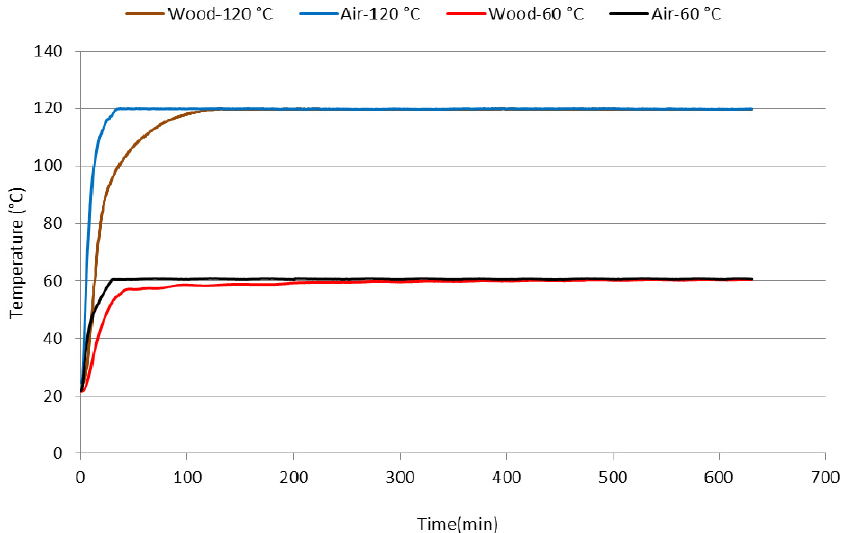
Figure 1. Temperatures in the dryer and in samples during the thermal treatment at 60 °C and 120 °C.